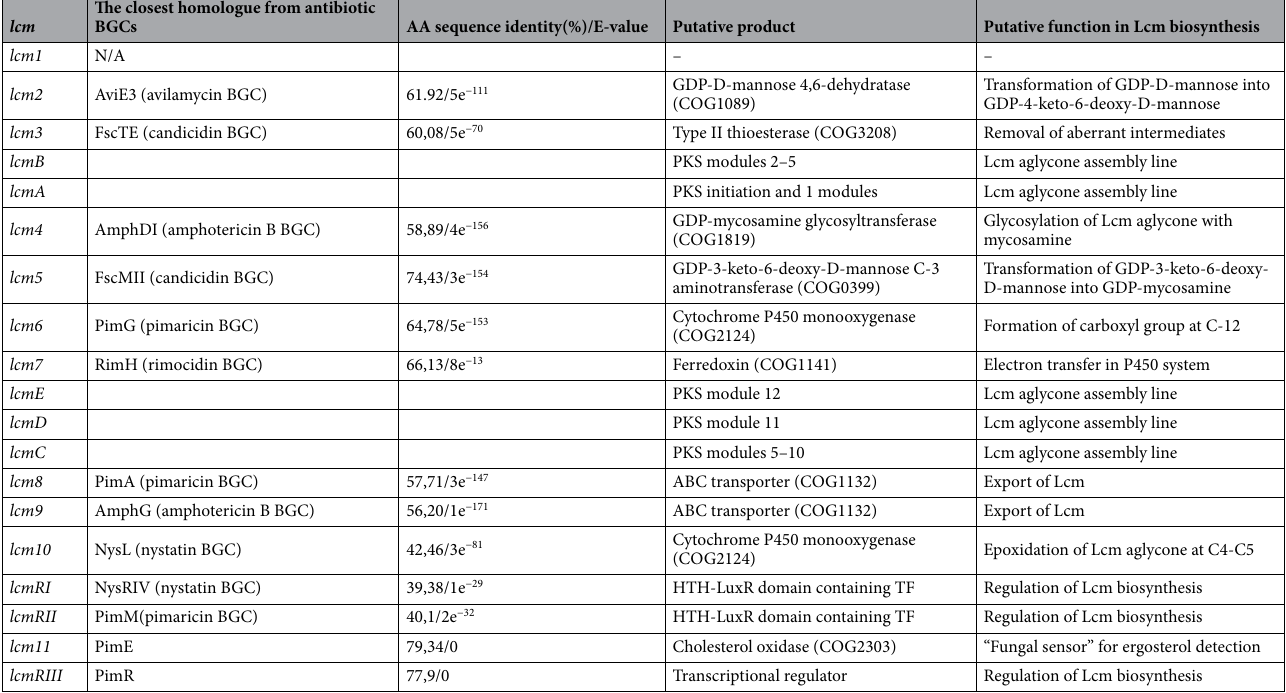
Table 1. Description of the ORFs discovered in lcm gene